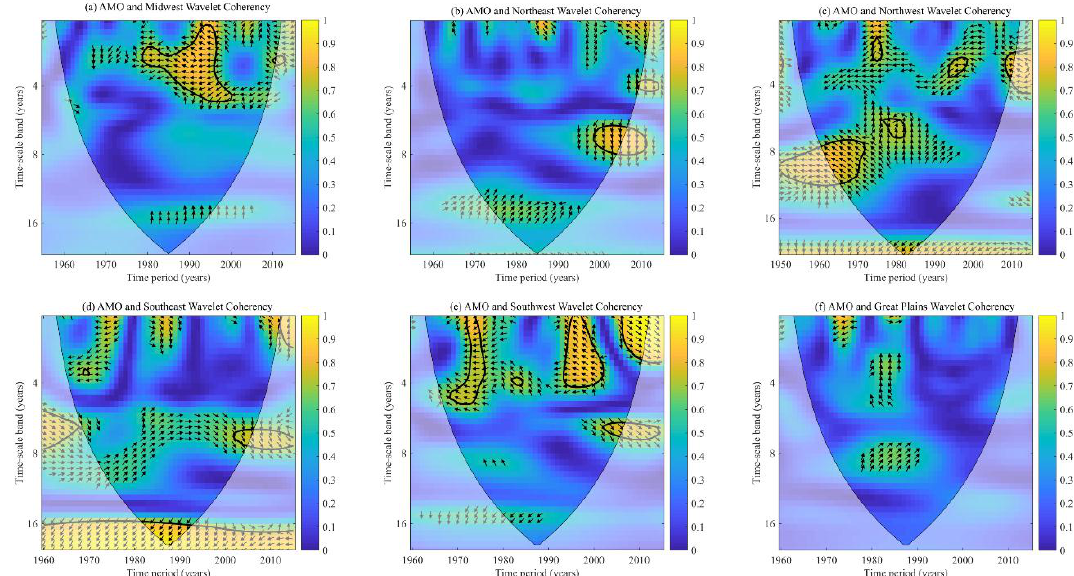
Figure 12. Wavelet coherency (WTC) spectrums between AMO and the regional streamflow of ( a ) Midwest; ( b ) Northeast; ( c ) Northwest; ( d ) Southeast; ( e ) Southwest; and ( f ) Great Plains. Warmer (yellow) color represents a higher correlation between the two time series. The arrows indicate the relative phase relationship within the significant zones of higher correlation.